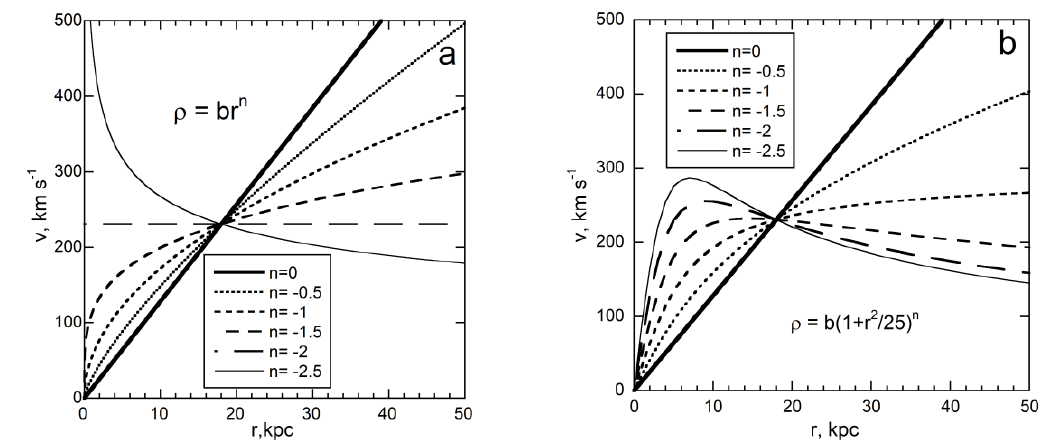
Figure 12. Simulated RC for oblate bodies with varying internal density, calculated for c / a = 0.1 = (1 − e 2 ) 1 2 and M in = 10 11 M sun at 18 kpc. An edge is not assumed: ( a ) Power law; ( b ) Formulae resembling that of Binney and Tremaine [43], which these authors used to cancel terms and make the integral tractable. The case of n = − 3 / 2 has the same shape as the result provided by Figure 2.13 in Ref. [43]), which to our knowledge is the only analytical solution heretofore available for an oblate spheroid.